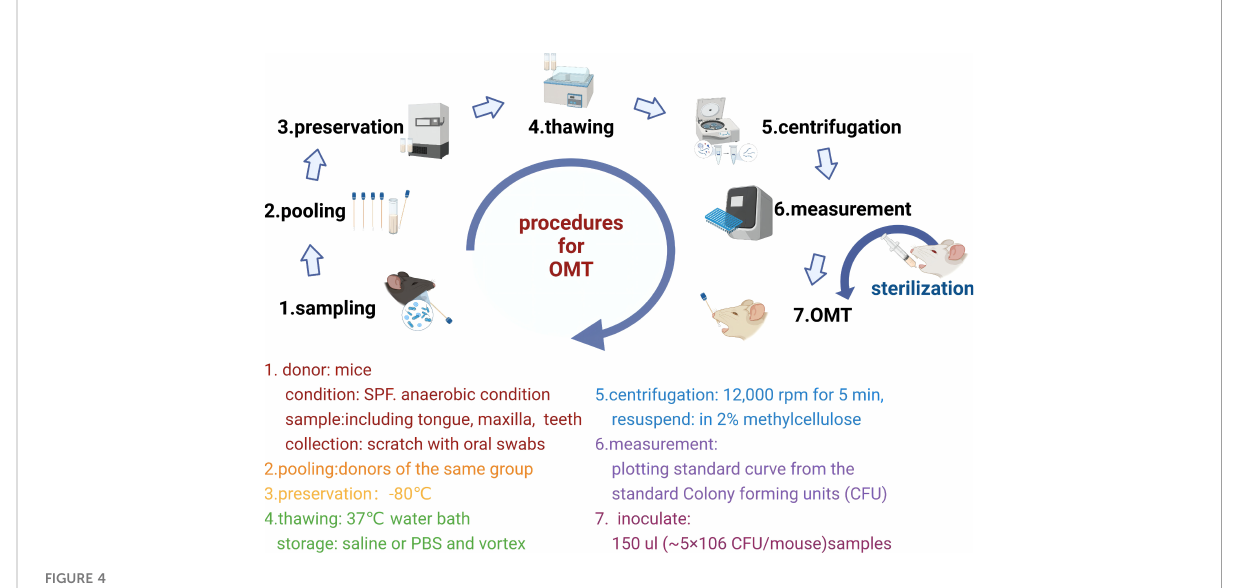
FIGURE 4 Flowchart of a standardized oral microbiota transplantation